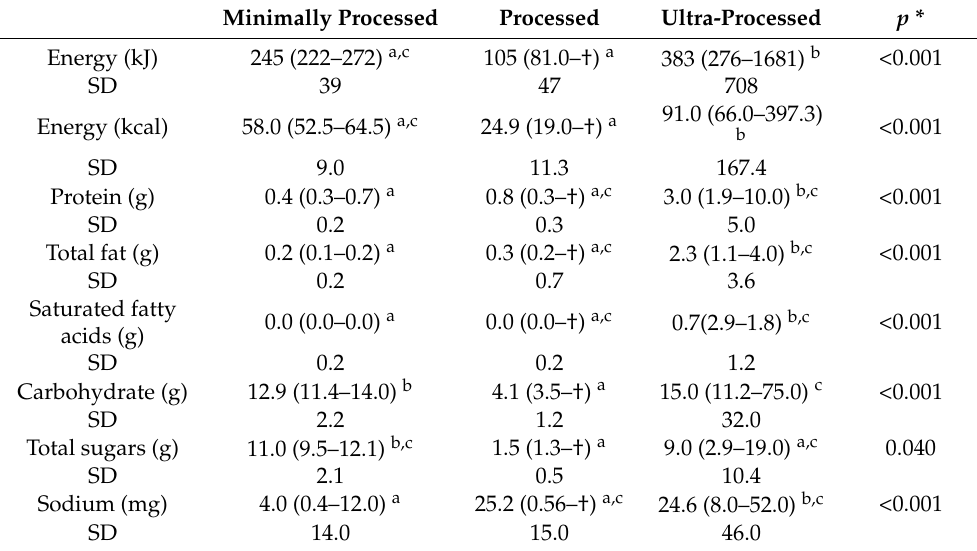
Table 5. Nutrition information per 100 g across processing classification (NOVA) for CACFs consid- ered in the study.